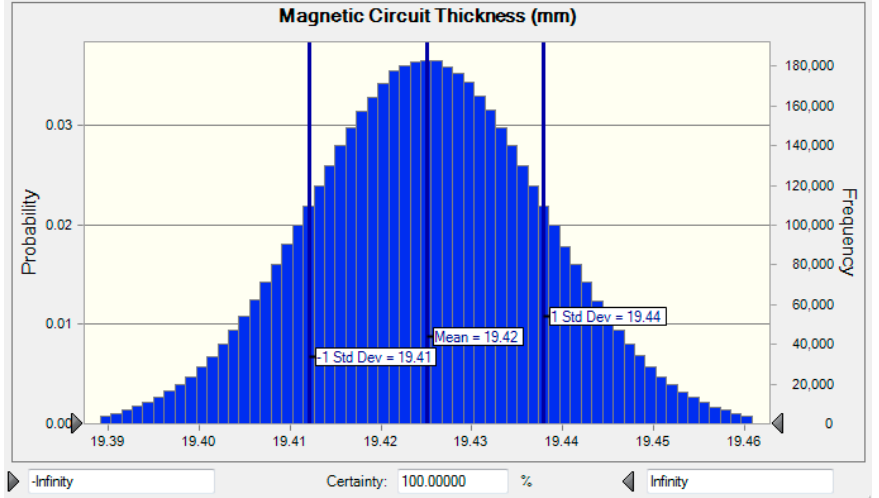
Figure 23. Performance distribution of thickness minimization by 3 sigma level.